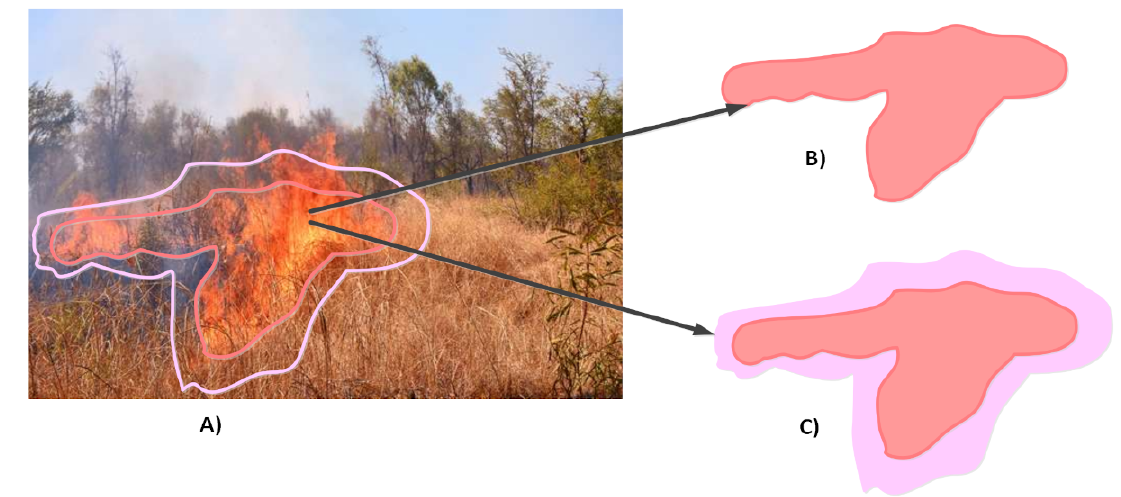
Figure 3. ( A ) Bushfire modeled using either a ( B ) crisp spatial object or a ( C ) vague spatial object made of kernel (red colored) and conjecture (pink colored) parts.